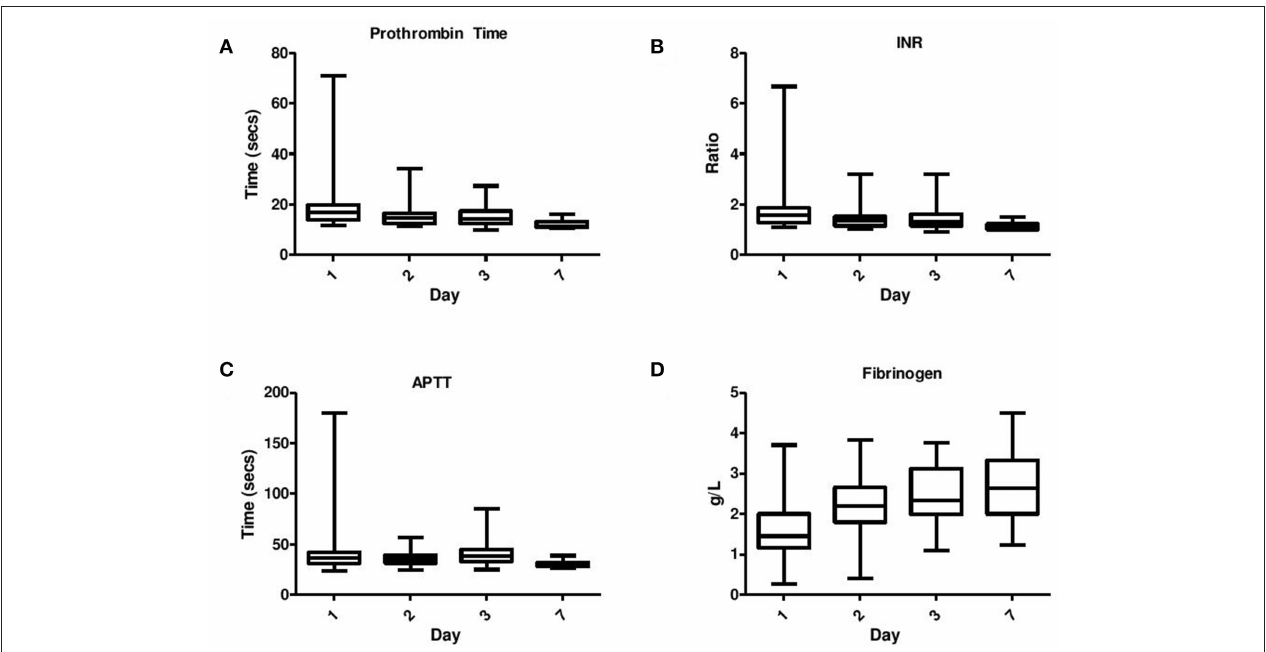
FIGURE 1 | Serial daily coagulation values in neonatal encephalopathy analyzed on day 1–day 7 including (A) Prothrombin time, (B) INR, (C) APPT, and (D) Fibrinogen.